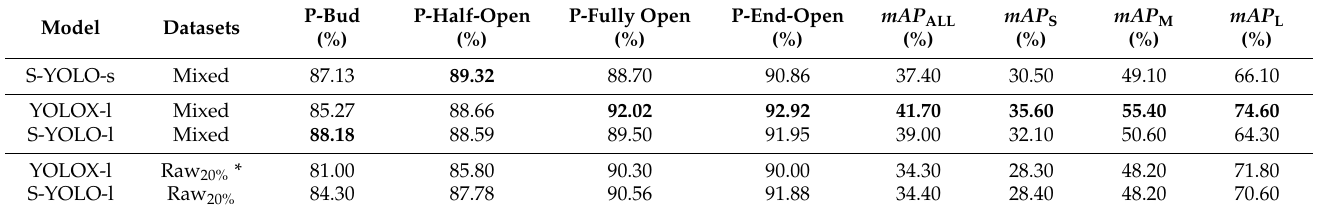
Table 8. Comparison results of YOLOX-l and S-YOLO-l with similar parameters (54.15 M and 51.37 M) on mixed and raw datasets (all using